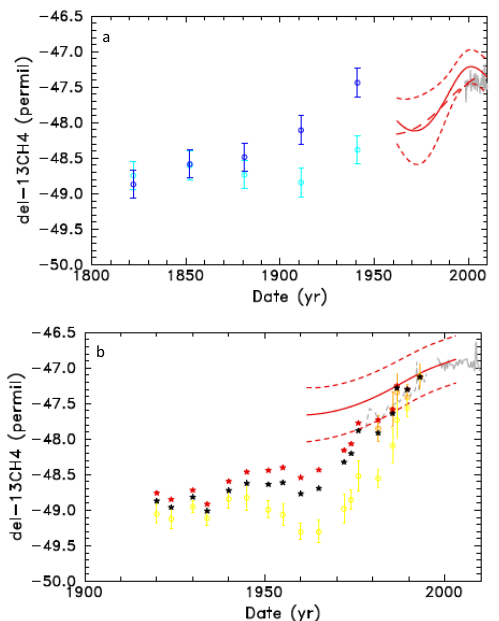
Figure 7: Multi-­‐site δ 13 C(CH 4 ) scenarios compared with direct atmospheric measurements (solid grey lines), atmospheric archive data from Cape Grim (dashed grey line) and ice core data (dots). The red continuous lines are the “best-­‐estimate” scenarios for each hemisphere with uncertainties (short dashed lines). The red long-­‐dashed-­‐line is the SH scenario shifted by 0.5‰ a: NH raw δ 13 C(CH 4 ) data (light blue dots) and δ 13 C(CH 4 ) data corrected for firn fractionation from the EUROCORE ice core (Sapart et al. 2012). b: SH raw δ 13 C(CH 4 ) firn and ice data at DEO8 (yellow dots) and the same data corrected for firn fractionation with the CSIRO model (orange dots) (Francey et al., 1999, Ferretti et al., 2005), with the LGGE-­‐GIPSA model using regular diffusivity (black stars) and with the LGGE-­‐GIPSA model but with “slightly modified diffusivity” as in Fig. 4 (red stars). The grey lines represent continuous atmospheric monitoring data from the NOAA-­‐ESRL network (NH and SH).